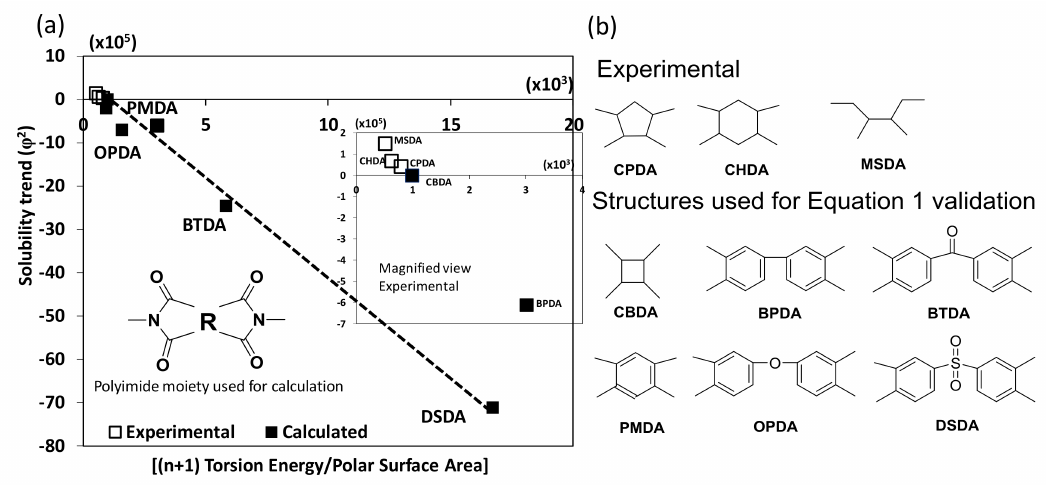
Figure 3. ( a ) Biopolyimide structure-solubility relationship. The calculated test samples were utilized for the validation of the solubility trend. Positive values of ϕ 2 represent soluble biopolyimide, while the negative values indicate insoluble biopolyimide. ( b ) The structures of “R” for various dianhydrides are shown for the experimental and calculated biopolyimide